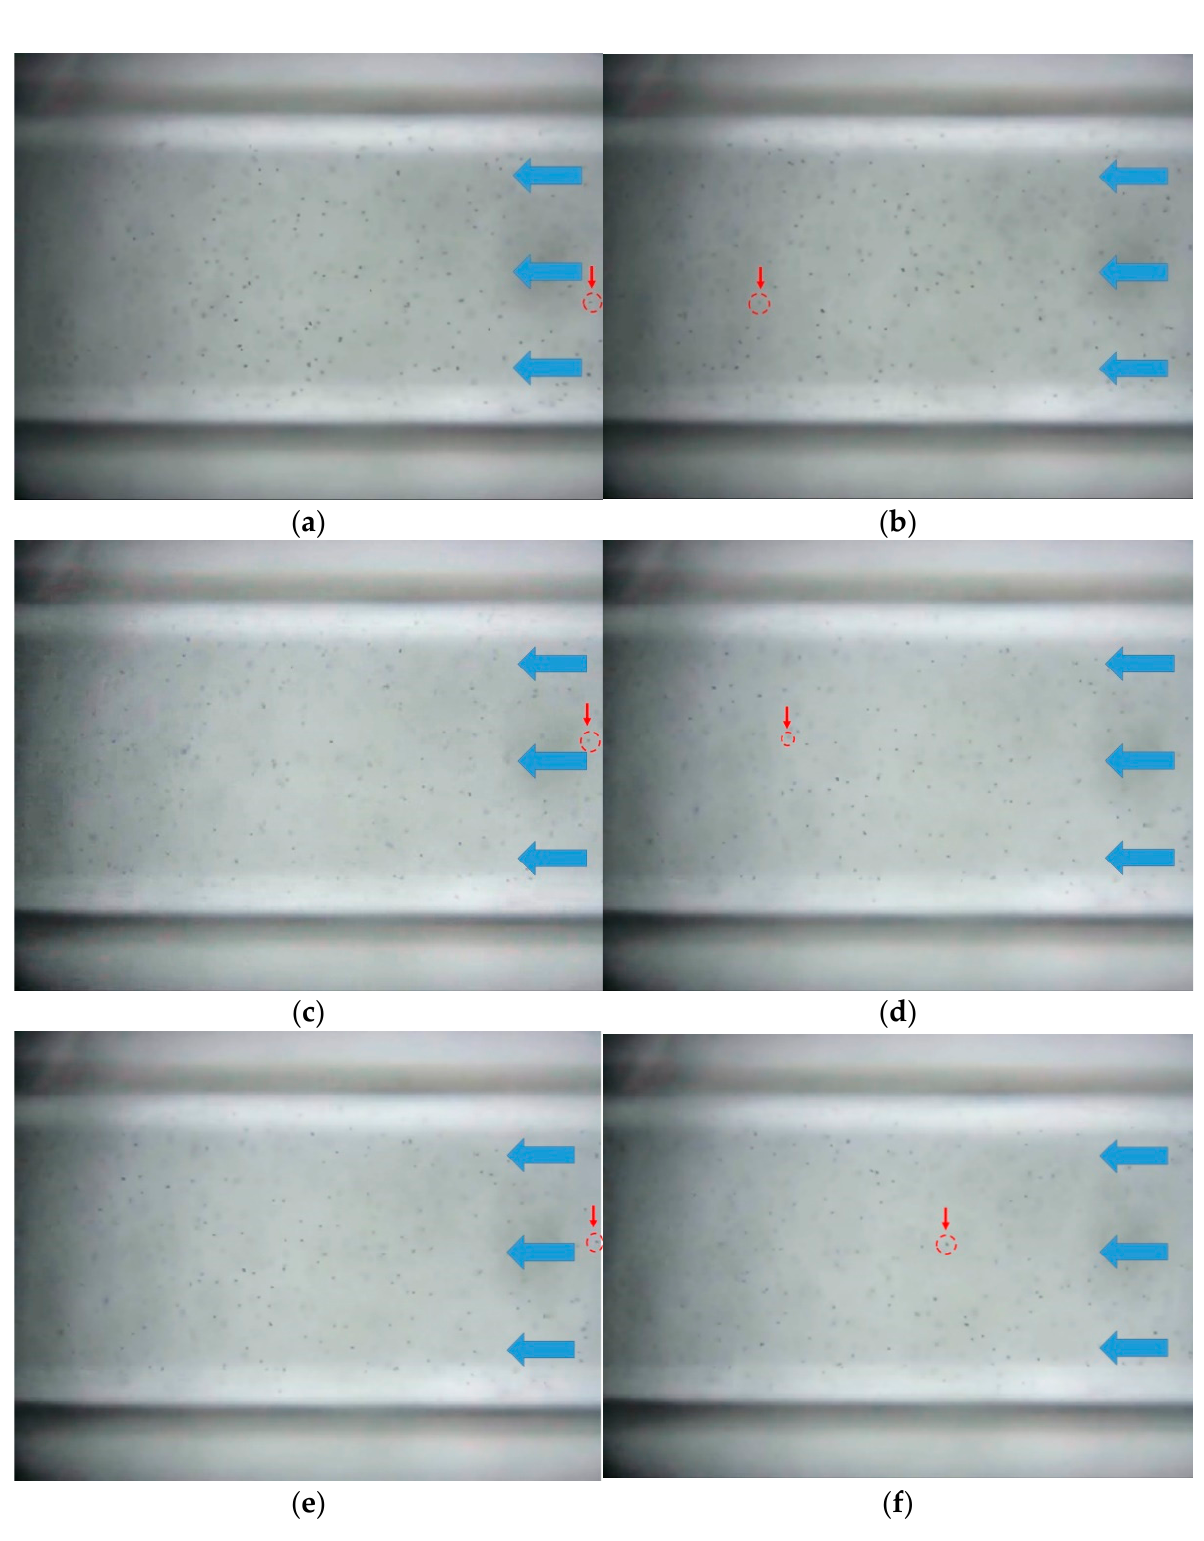
Figure 7. Experimental results of flow characteristics of copper contaminants–capillary tube middle of center: ( a ) Particle position before moving 1; ( b ) particle position after moving 1; ( c ) particle position before moving 2; ( d ) particle position after moving 2; ( e ) particle position before moving 3; ( f ) particle position after moving 3.